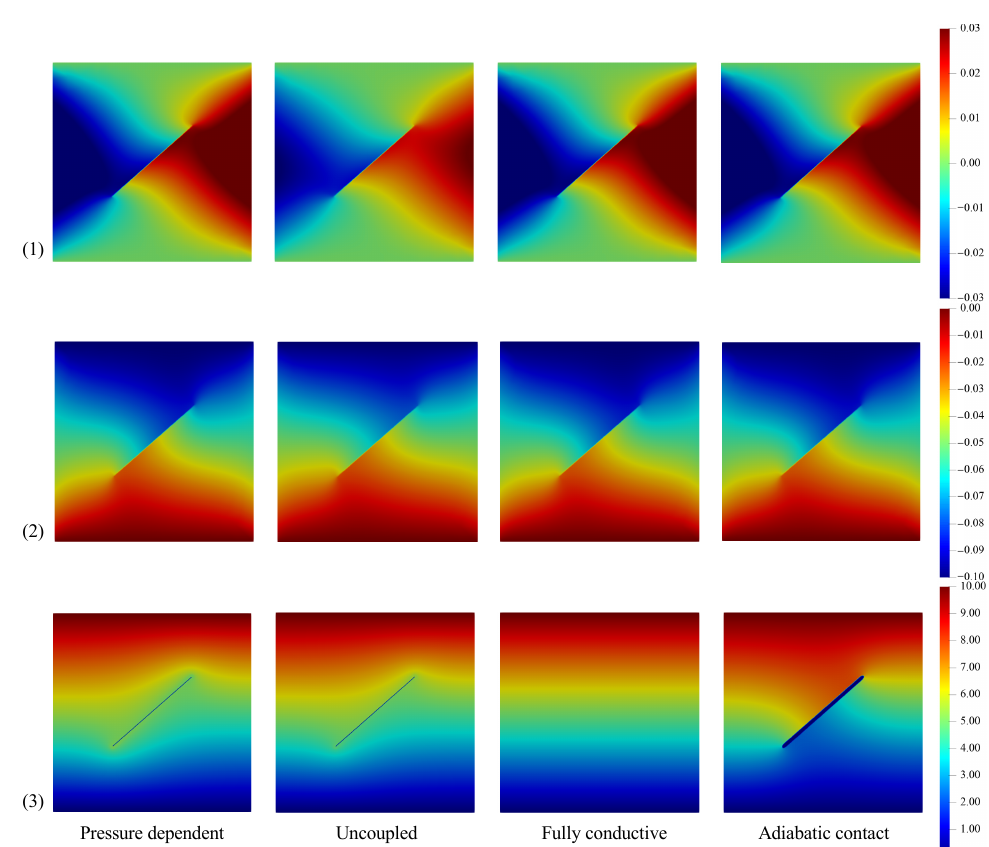
Figure 9. Contour plots of ( 1 ) Displacement in the X direction; ( 2 ) displacement in the Y direction; ( 3 ) temperature contours at the last step for four different thermal conditions.